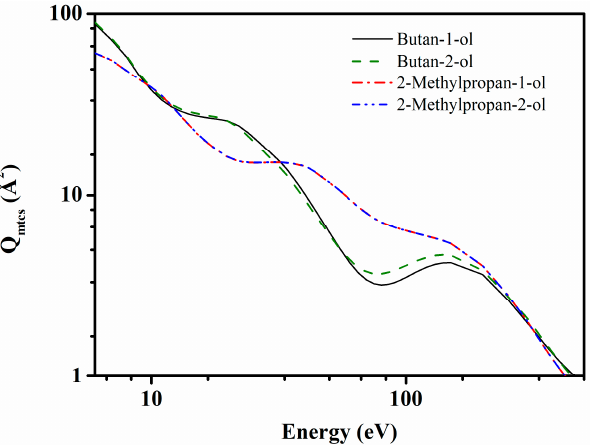
Figure 10. Momentum transfer cross-section of butanol isomers (present): solid (black) line represents butan-1-ol, dashed (olive) line is for butan-2-ol, dash-dot (red) line is for 2-methylpropan-1-ol and dash-dot-dot (blue) line represents 2-methylpropan-2-ol.